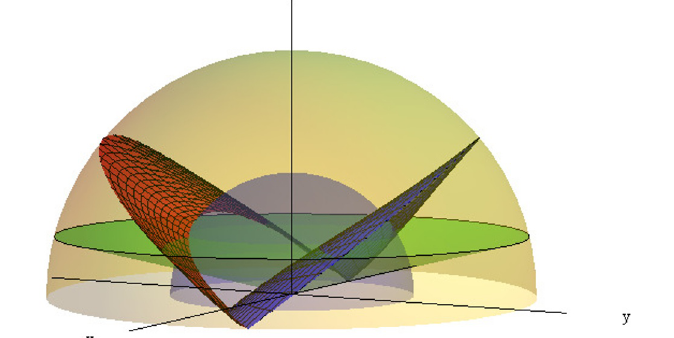
Figure 4 . Fundamental region between two domes and two constant- (cid:28) surfaces, together with the regularizing cone (in green). The parameter J is set to i= 2. The integration is to be taken between the domes as well as between the two equal-time surfaces and above the cone. This image was obtained from the coordinate transformation described in the